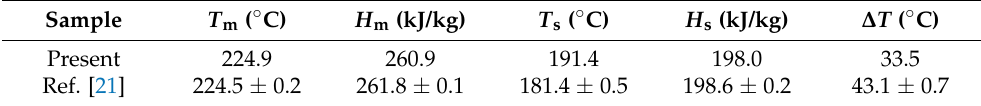
Figure 4. DSC curves of the inositol. Table 2. Phase-change properties of the